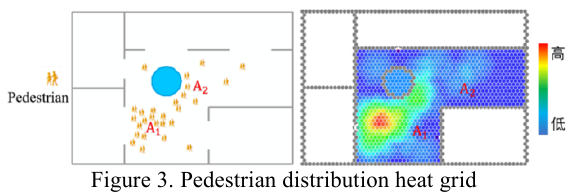
Figure 3. Pedestrian distribution heat grid